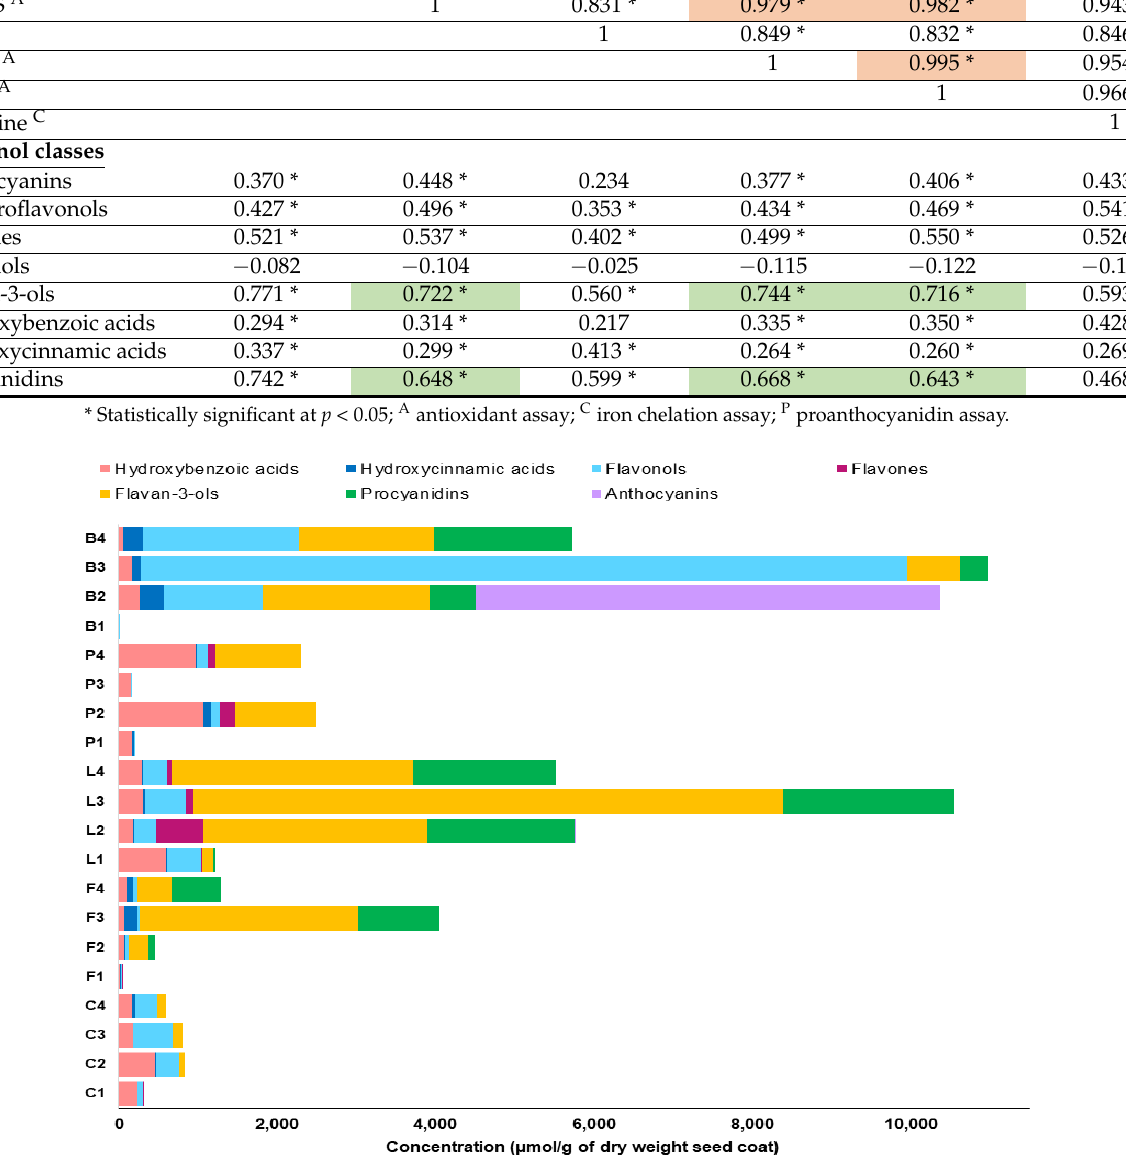
Figure 4. Cumulative concentrations of major polyphenol subclasses in seed coat extracts in µ mol/g dry weight using the targeted method . This figure was derived from Elessawy et al. [26] and the concentrations of individual polyphenols are given in Tables S4–S8. Letters on y-axis refer to different pulse crops; C: chickpea, F: faba bean, L: lentil, P: pea and B: common bean, whereas numbers refer to different seed coat colors. For example, L2 refers to black seed coats of Indianhead lentil (see Table 3 for